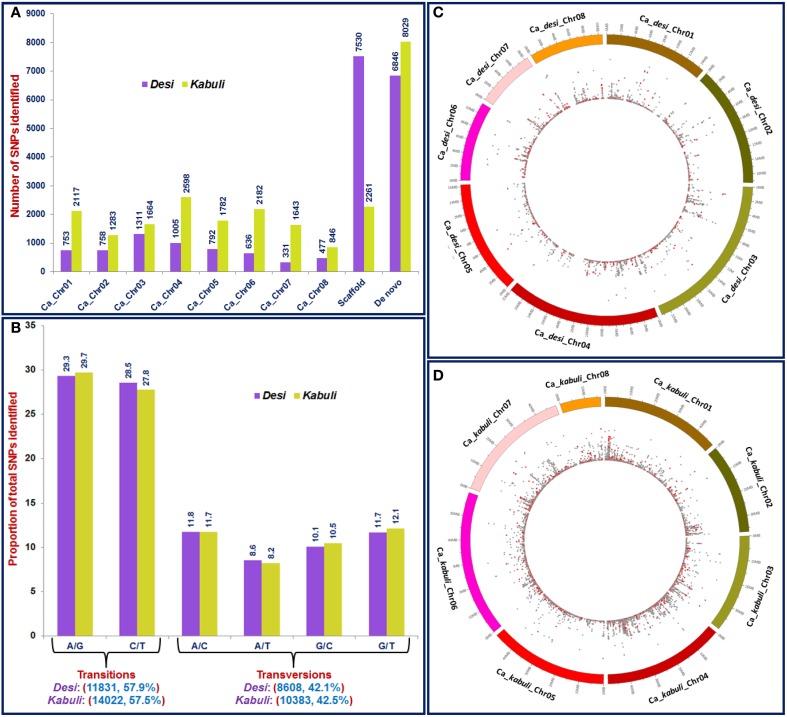
(A) Frequency and distribution of 44,844 SNPs identified from desi and kabuli chickpea using reference genome (eight chromosomes and unanchored scaffolds)- and de novo-based GBS assays. (B) Percentage distribution of transition and transversion SNPs identified using GBS assay. The relative distribution of 20,178 SNPs physically mapped on eight chromosomes of desi
(C) and kabuli
(D) genomes are depicted in the Circos circular ideogram. The outermost circles represent the eight chickpea chromosomes coded with different colors, whereas the innermost circles display the distribution of SNPs, including non-synonymous SNPs (marked with red dots) identified through GBS assay.